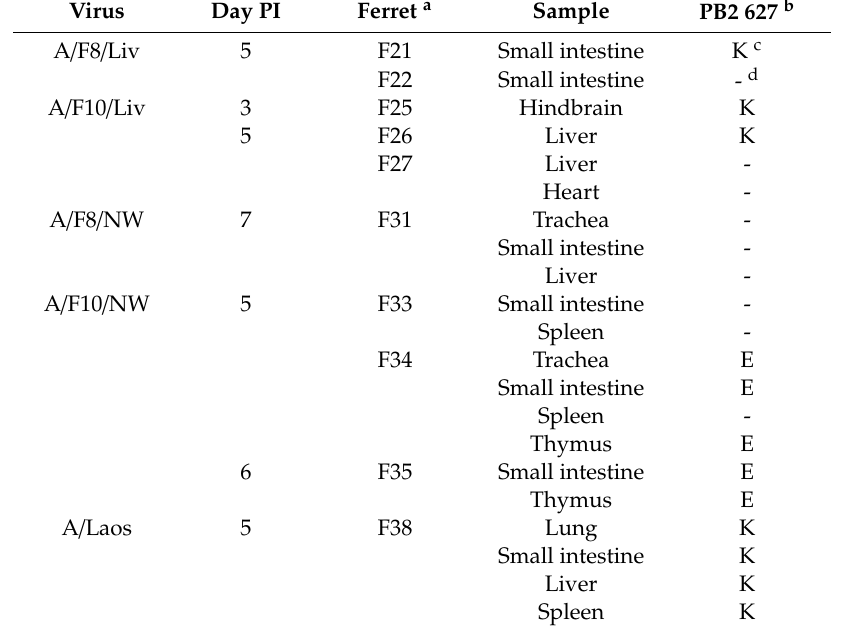
Table 7. Identification by sequencing of the AA at PB2 627 in A / Laos following a second virus passage in